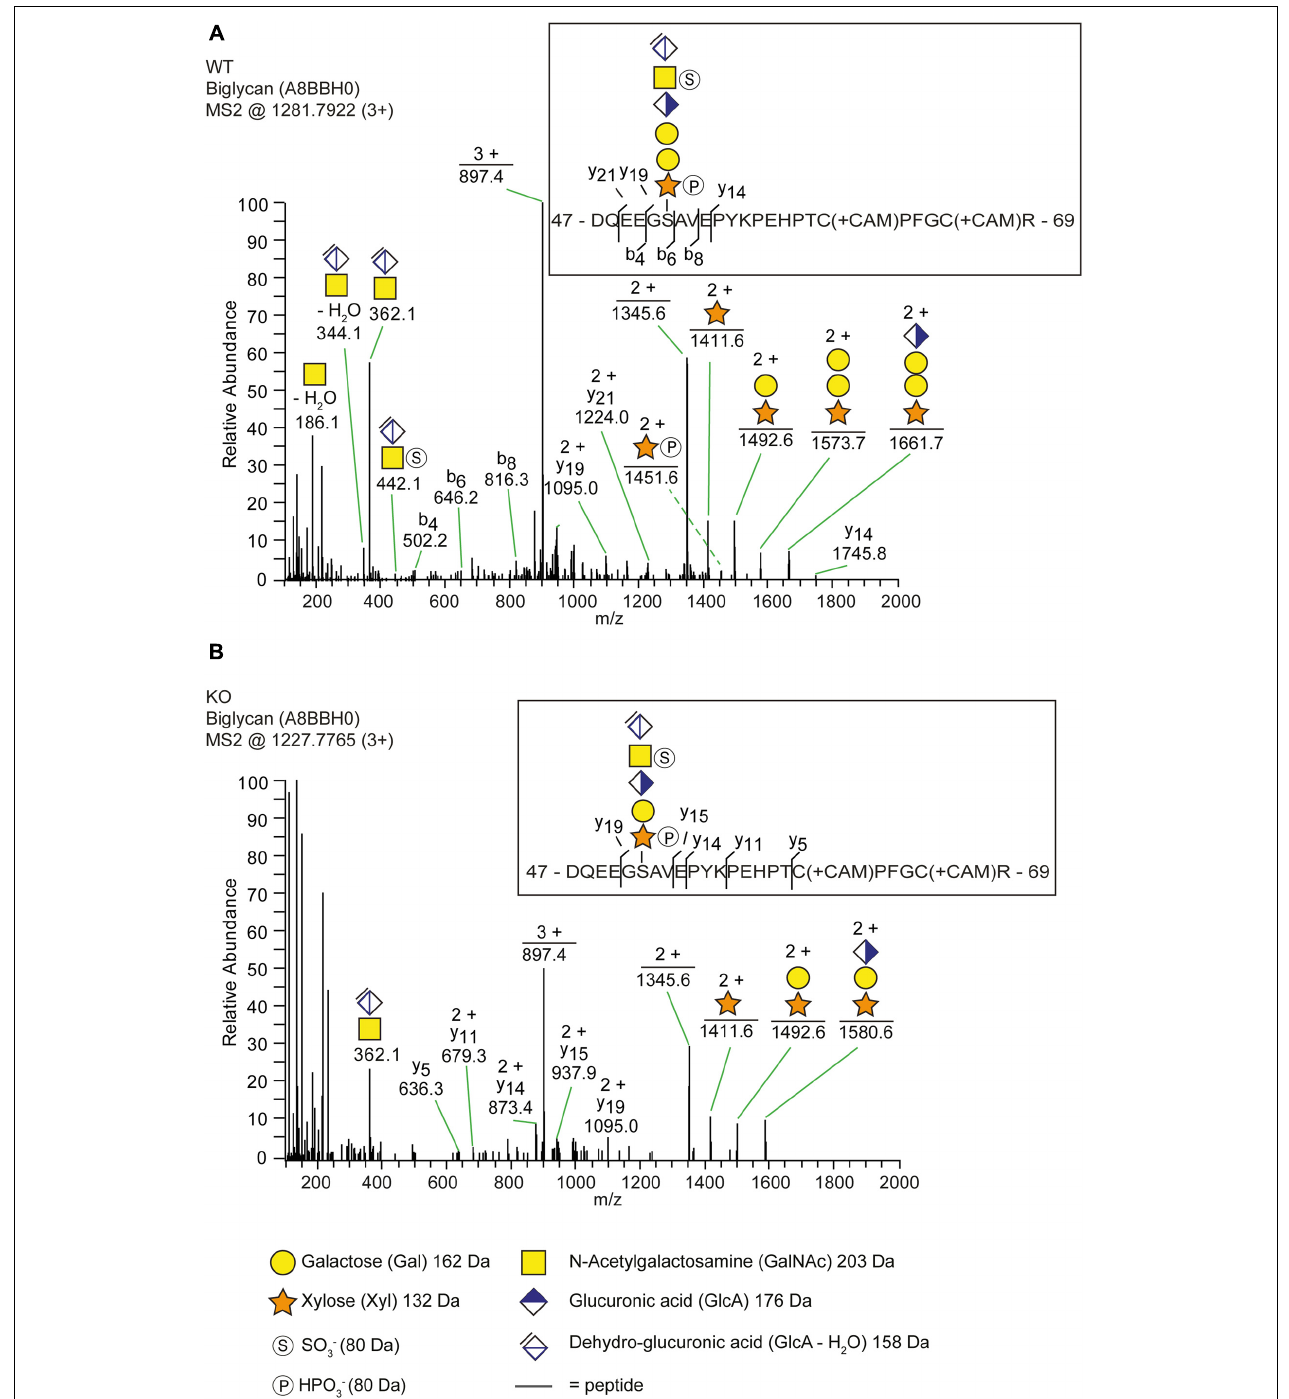
FIGURE 2 | The identification of a trisaccharide linkage region in the b3galt6 − / − zebrafish. (A,B) MS2 fragment mass spectra of CS-glycopeptides derived from biglycan (UniProt: A8BBH0) showed different linkage regions in WT compared to the b3galt6 − / − zebrafish. (A) The peptide (DQEEGSAVEPYKPEHPTCPFGCR) in WT zebrafish was modified with a residual hexasaccharide structure, corresponding to the canonical tetrasaccharide linkage region ( m/z 1281.79; 3+). The hexasaccharide structure was modified with one sulfate group (SO − 3 ) at the subterminal GalNAc residue and one phosphate group (HPO − 3 ) at the xylose residue ( Supplementary Figure S7 ). (B) The peptide (DQEEGSAVEPYKPEHPTCPFGCR) in b3galt6 − / − zebrafish was modified with a residual pentasaccharide structure, corresponding to a non-canonical trisaccharide linkage region ( m/z 1227.78; 3+). The pentasaccharide structure was modified with two phosphate/sulfate groups. Their exact positioning and identity could not be determined due to low intensities of corresponding ion peaks, and the positions are therefore assigned in analogy of the WT structure.